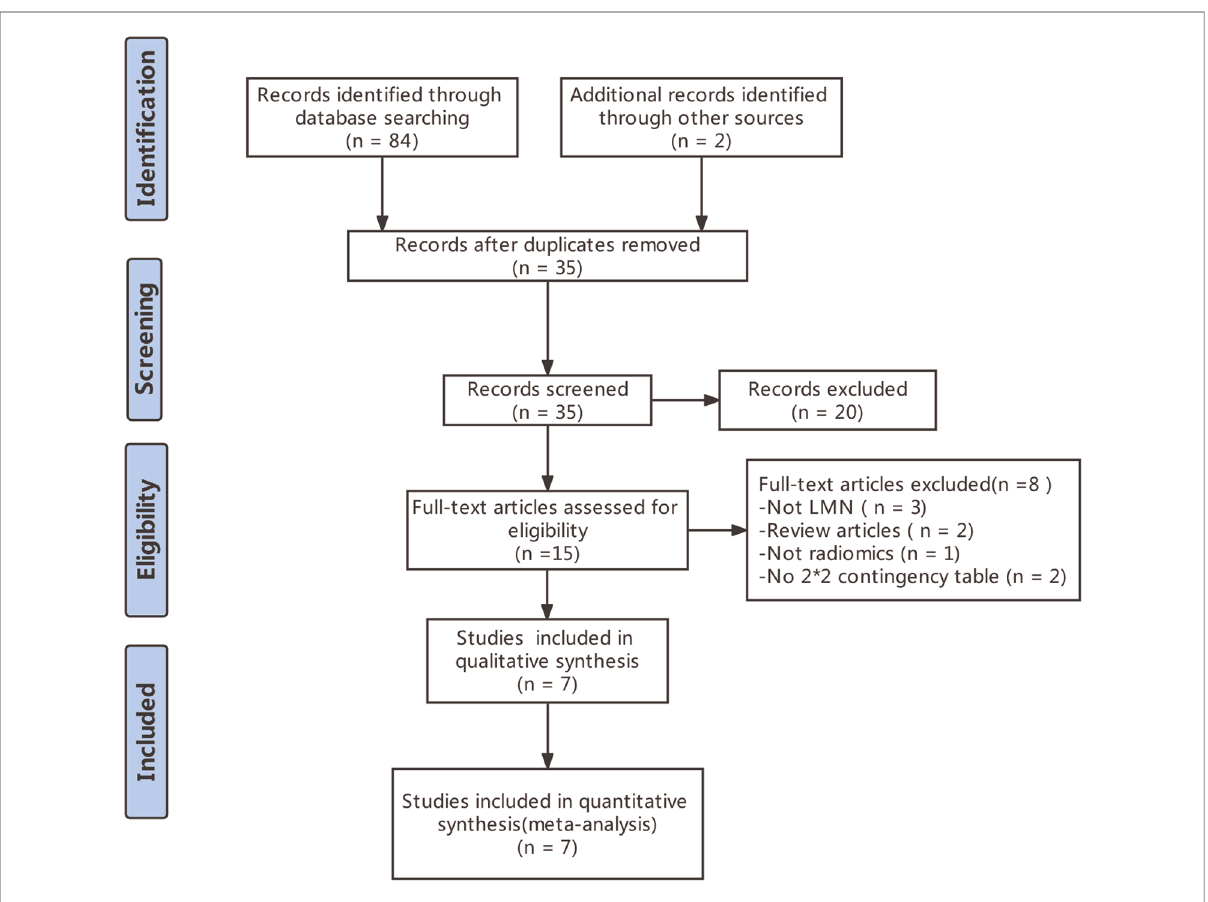
FIGURE 1 The PRISMA fl owchart of the selection